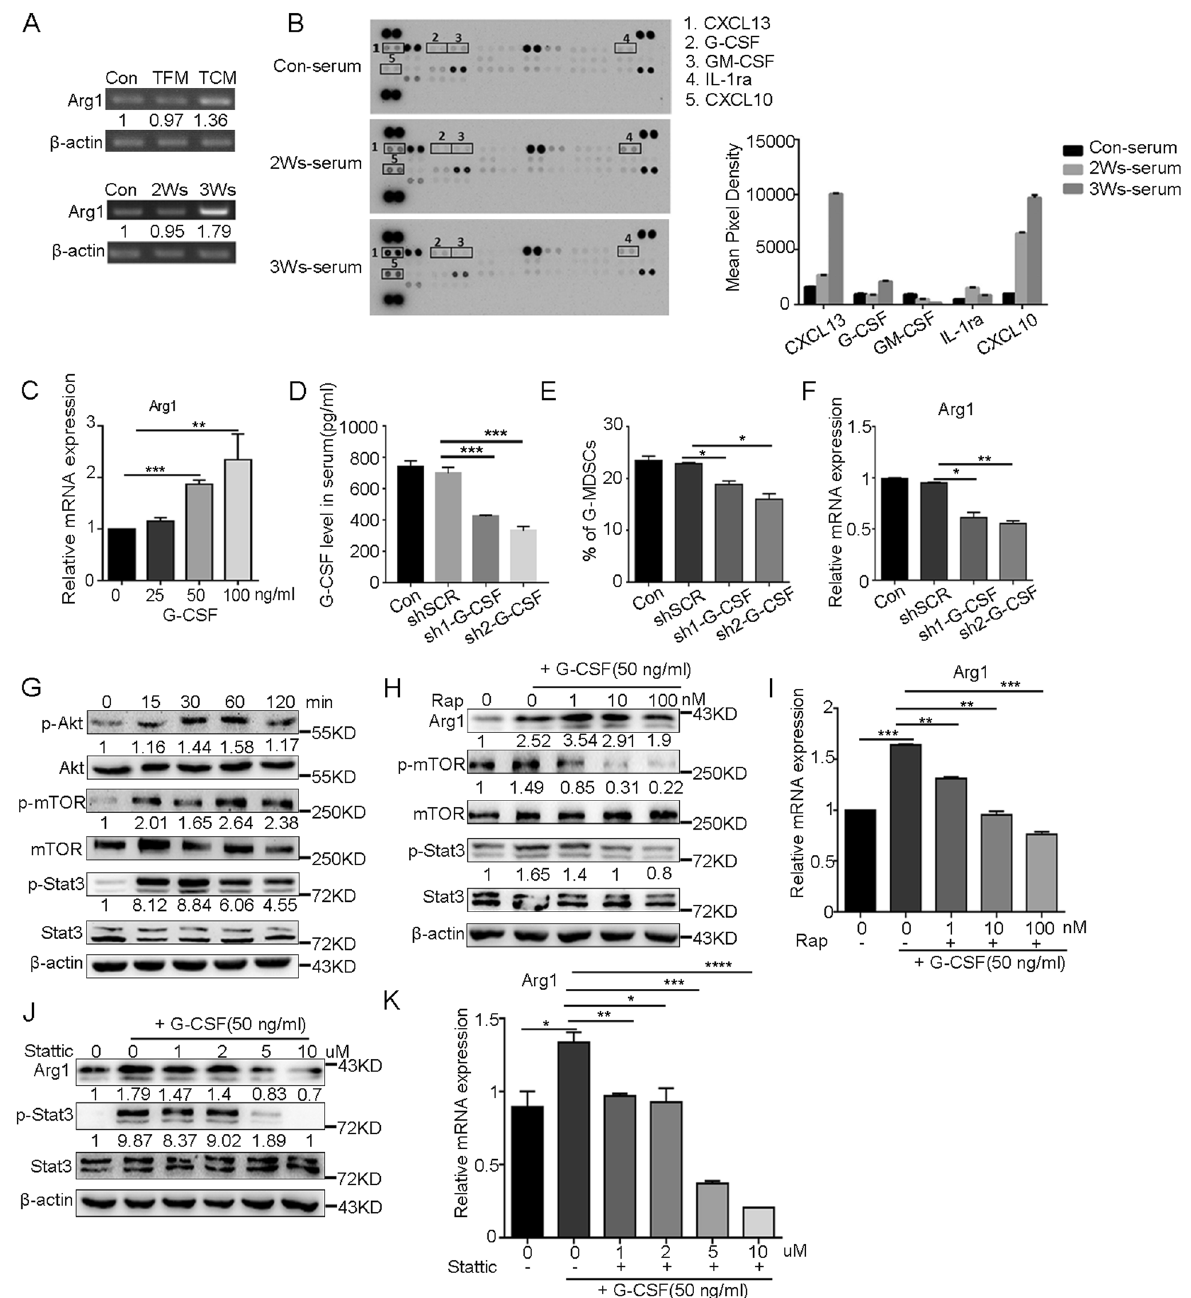
Fig. 5 G-CSF promotes the expression of immunosuppressive genes in G-MDSCs by activating the PI3K-Akt/mTOR signaling pathway. A G-MDSCs taken from bone marrow of normal mice were cultured with tumor-free media (TFM), tumor cell-conditioned media (TCM) or serum from mice bearing tumors for different durations for 2 h, and the expression of Arg1 was analyzed by semi-quantitative PCR. B The expression pro fi les of various cytokines in the serum of mice bearing tumors for 0, 2, or 3 weeks were assessed using a cytokine array. C The expression of Arg1 in G-MDSCs taken from bone marrow of normal mice was analyzed by Q-PCR after incubation with different concentrations of G-CSF for 2 h ( n = 5). D The level of G-CSF in serum was analyzed by ELISA after mice were infected with lentiviruses carrying shScramble (shSCR), sh1-G- CSF, or sh2-G-CSF ( n = 4). E The proportion of G-MDSCs in peripheral blood was analyzed by FCM after mice were infected with lentiviruses carrying shSCR, sh1-G-CSF, or sh2-G-CSF ( n = 4). F The expression of Arg1 in G-MDSCs from peripheral blood was analyzed by Q-PCR after mice were infected with lentiviruses carrying shSCR, sh1-G-CSF- or sh2-G-CSF ( n = 4). G The expression of Akt, p-Akt, mTOR, p-mTOR, Stat3, and p-Stat3 in G-MDSCs taken from the bone marrow of normal mice was analyzed by western blot after G-CSF (50 ng/ml) was added to the culture and incubated for the indicated minutes. H G-MDSCs taken from the bone marrow of normal mice were cultured in vitro with G-CSF (50 ng/ml) and different concentrations of rapamycin for 2 h, and the expression of Akt, p-Akt, mTOR, p-mTOR, Stat3, and p-Stat3 was detected by western blot. I The expression of Arg1 was detected by Q-PCR. The cells were treated as described in H ( n = 4). J G-MDSCs taken from the bone marrow of normal mice were cultured in vitro with G-CSF (50 ng/ml) and different concentrations of stattic for 2 h, and the expression of Stat3 and p-Stat3 was detected by western blot. K The cells were treated as described in J , and the expression of Arg1 was detected by Q-PCR ( n = 4). Results are mean ± SD. Unpaired t- test was used to determine signi fi cance (* p < 0.05, ** p < 0.01, *** p < 0.001 and **** p < 0.0001).